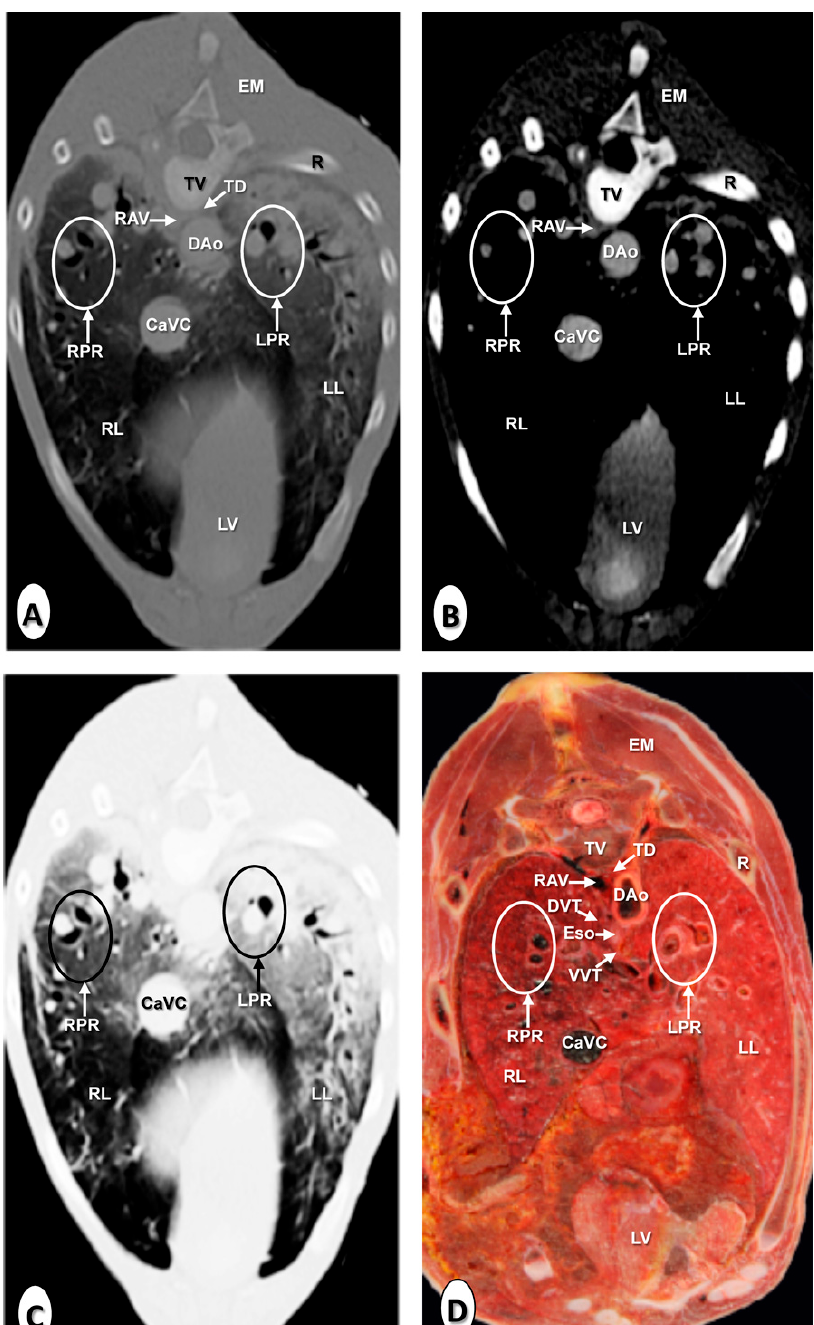
Figure 7. Transverse images at the level of the apex of the heart. ( A ) CT bone window; ( B ) CT mediastinal window; ( C ) CT lung window; and ( D ) anatomical section. These images are displayed so that the right side of the foal is to the viewer’s left and the dorsal view is at the top. Caudal vena cava (CaVC); descending aorta (Dao); dorsal vagal trunk (DVT); epaxial muscles (EM); left lung (LL); left pulmonary root (LPR); left ventricle (LV); rib: Costal bone (R); right azygos vein (RAV); right lung (RL); right pulmonary root (RPR); thoracic duct (TD); thoracic vertebra (TV); and ventral vagal trunk (VVT).